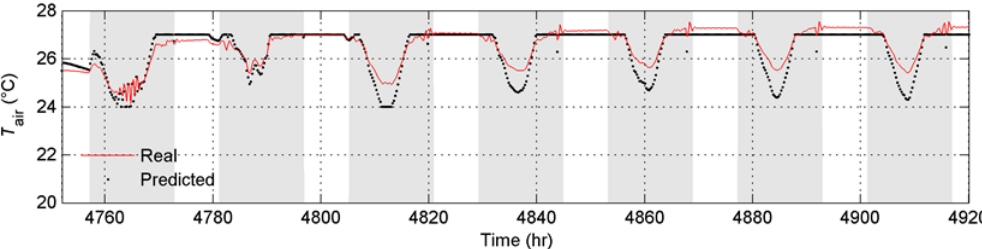
Figure 14. Comparison between actual indoor air temperature ( T air ) and its prediction in the MPC with OF C and PH of 18 h.